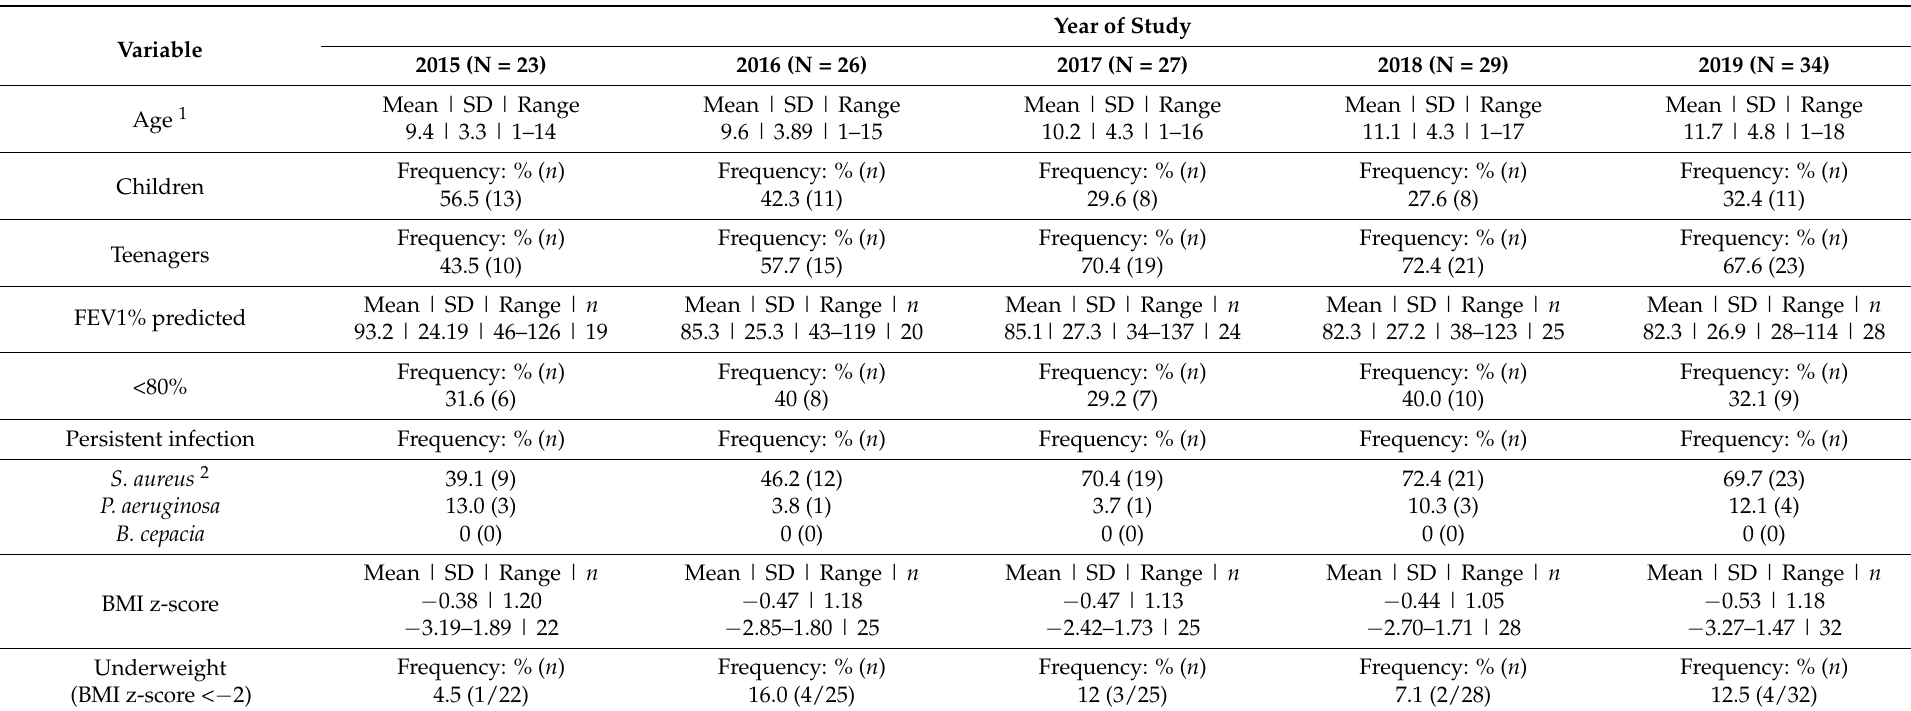
Table 1. Sample characteristics per year of